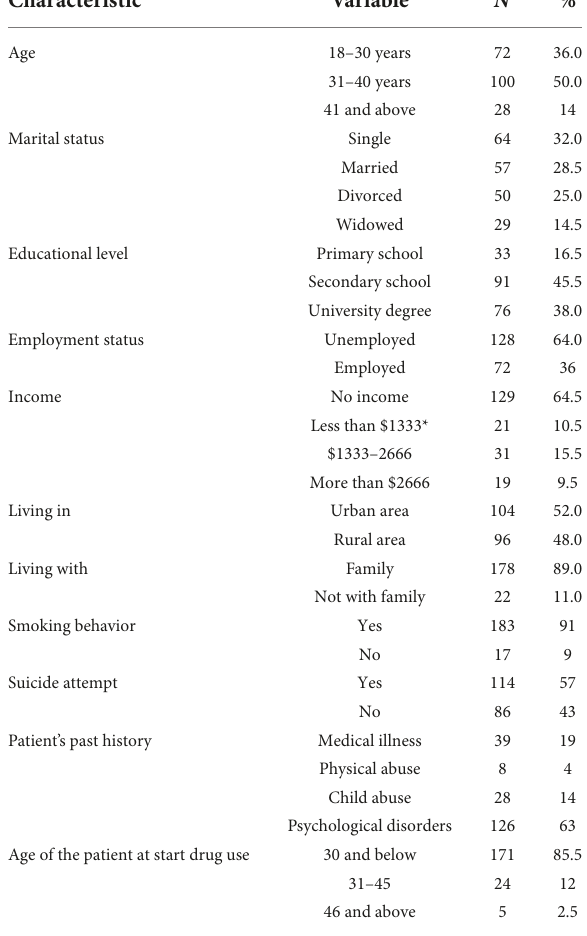
TABLE 1 Socio-demographic characteristics of female psychiatric patients with substance use (SU) ( n = 200).